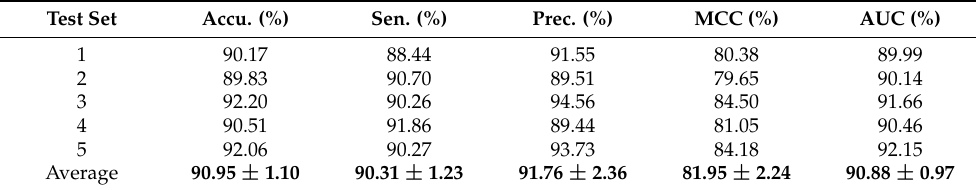
Table 3. MSPEDTI outcomes for 5CV on ion channel dataset.